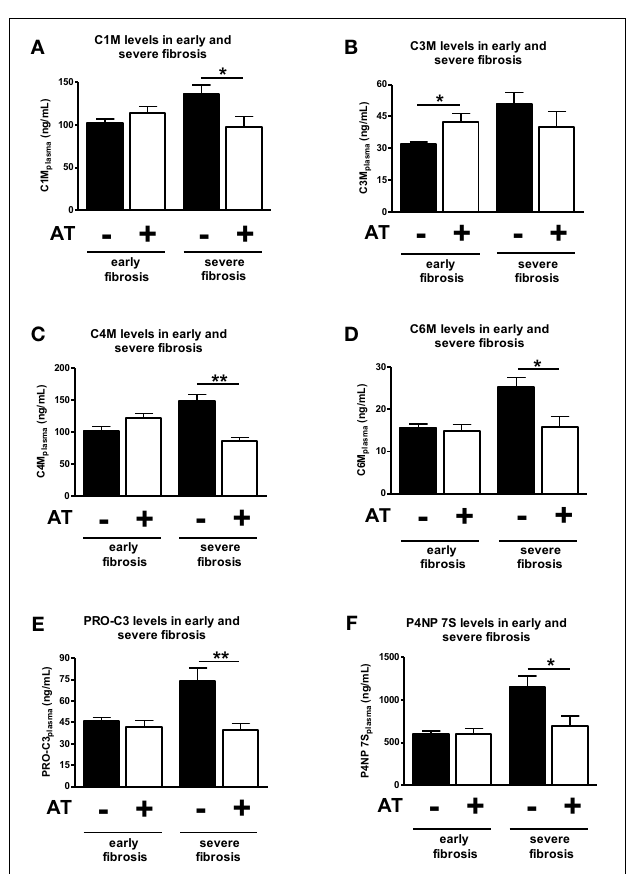
FIGURE 4 | Comparison of early and severe fibrosis for all ECM markers in atorvastatin treated or untreated animals. Different points of time were pooled into groups early fibrosis (T1–T3) and group servere fibrosis (T4 and T5) and separated by statin treated ( + AT) and untreated ( − AT) animals. Asterisks indicate statistical significance as indicated by bars. ( ∗ p < 0 . 05, ∗∗ p < 0 . 01). of fibrosis (after 4 and 5 weeks of BDL) ( Figure 4 ). These data suggest that these novel ECM degradation and formation mark- ers might reflect the amount of fibrosis, as well as the effect of an anti-fibrotic treatment before the amount of ECM changes notably in the